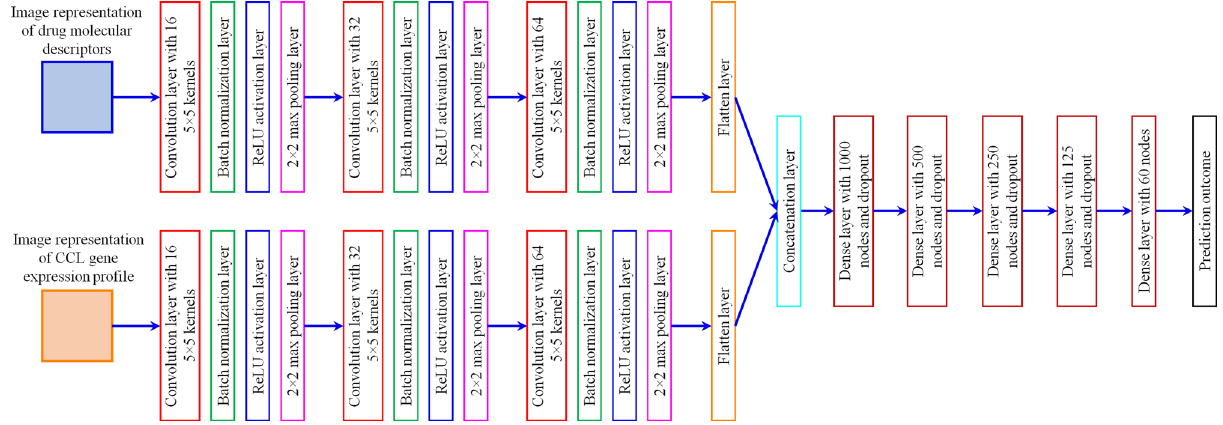
Figure 3. Architecture of the convolutional neural network (CNN) used for predicting drug response based on image overfitting, and the rest one data fold was used for testing the prediction performance. A total of 20 cross-valida- tion trials were conducted. The prediction performance was measured by the coefficient of determination (R 2 ). To assess the utilities of different image representations, the same CNN models were also trained with REFINED and DeepInsight images. The only difference was when training with DeepInsight images the stride value for moving the convolution kernels was changed from 1 to 2, in order to accommodate the larger input images. Due to the larger input images and consequently larger feature maps and concatenation layer, the number of trainable parameters in the model increased from 1,307,218 for IGTD and REFINED images to 2,715,218 for DeepInsight images. Because the larger input images consumed more memory, we always encountered the out-of-memory error when training models using static data of DeepInsight images. To avoid the error, a data generator mechanism had to be implemented to generate the training data batch by batch on the fly instead of using static data. The out-of-memory error never occurred in model training using static data of IGTD and REFINED images due to their smaller size, which demonstrated that the compact image representations of IGTD and REFINED indeed required less memory for model training. We also compared CNNs trained on IGTD images with prediction models trained on the original tabular data. Four prediction models, including LightGBM 28 , random forest 29 , single-network DNN (sDNN), and two- subnetwork DNN (tDNN), were included for the comparison. LightGBM is an implementation of the gradient boosting decision tree algorithm that uses techniques of gradient-based one-side sampling and exclusive feature bundling to speed up model training 28 . Random forest constructs multiple decision trees on random sub-samples of data and uses the average of their outcomes as the prediction 29 . sDNN was a fully connected neural network of six hidden layers. For LightGBM, random forest, and sDNN, the CCL gene expression profile and the drug molecular descriptors were concatenated to form the input vector. tDNN was also a neural network with dense hidden layers, but it includes two subnetworks for the input of gene expression profiles and drug molecular descriptors separately. Each subnetwork included three hidden layers. The outputs of the two subnetworks were concatenated and passed to another three hidden layers to make prediction. For a fair comparison, all predic- tion models were trained and tested through 20 tenfold cross-validation trials, with the same data partitions (i.e. training, validation, and testing sets) used for the cross-validation of CNNs with image representations. See Section 3 in the Supplementary Information for details of the prediction models and the model training process. Table 2 shows the drug response prediction performance obtained using different data representations and prediction models. CNNs with IGTD images provide the highest average R 2 across cross-validation trials on both CTRP and GDSC datasets. The average R 2 of CNN with REFINED images is similar to that of CNN with IGTD images, presumably because both IGTD and REFINED take a similar strategy to generate compact image representations with an intention of grouping similar features together in the image. CNN with DeepInsight images and tDNN with tabular data rank the third and the fourth on the CTRP dataset, while their ranks switch on the GDSC dataset. sDNN, LightGBM, and random forest with tabular data rank the fifth, sixth, and seventh on the two datasets, respectively. The two-tail pair-wise t-test is applied to evaluate the performance difference between CNN with IGTD images and other combinations of prediction models and data representations. The result shows that CNNs trained with IGTD images statistically significantly outperform (p-values ≤ 0.05) all other combinations, except CNNs trained with REFINED images for which the p-values do not make the cutoff. Because the DeepInsight images are much larger than the IGTD or REFINED images, the number of train- able parameters at least double (2,715,218 parameters vs. 1,307,218 parameters) for CNN models trained on DeepInsight images. To investigate how the larger input image size and consequent model size affect the model training speed, we compare the model training time (i.e. the time to train a prediction model to convergence) of CNNs with different image representations. For each cross-validation trial, we calculate the ratio between the model training time of CNN with DeepInsight or REFINED images and that of CNN with IGTD images. The ratio is then log2 transformed, so that a positive value indicates CNN with DeepInsight or REFINED images takes a longer time to train while a negative value indicates CNN with IGTD images takes a longer time to train. See Table 3 for the mean and standard deviation of the log2 ratio obtained in cross-validation. The one-sample